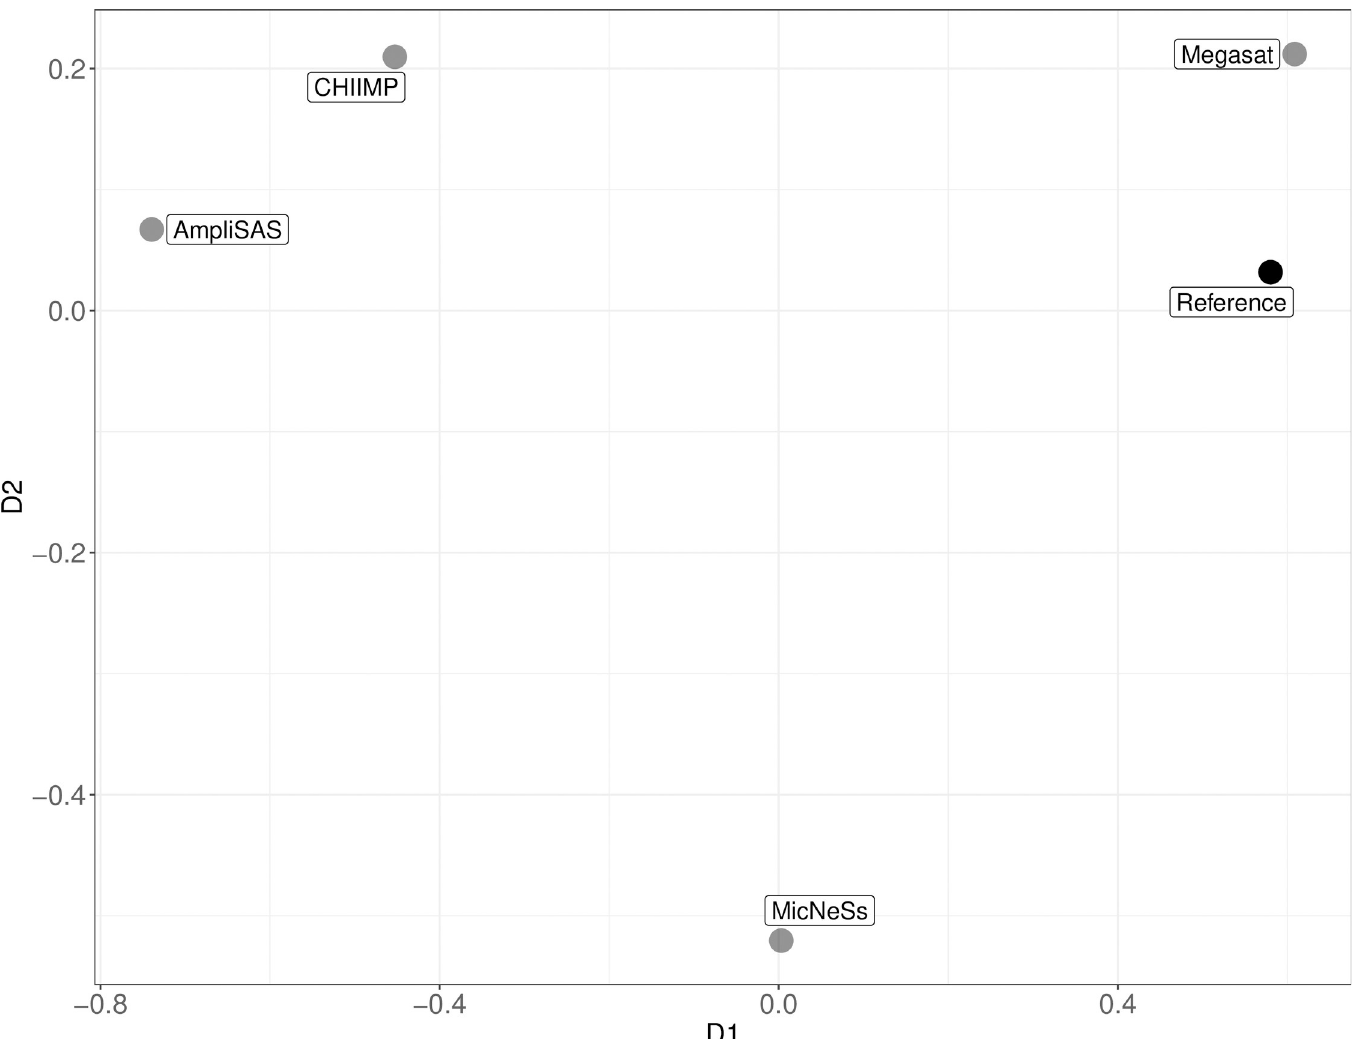
Fig 1. Multidimensional Scaling (MDS) of genotyping programs. Axes show distance values of distance matrix. Distance matrix was obtained from the comparison of consensus genotypes of each software and establishing minimum read depth of 16 (S2 Table in S1 File). The closer two programs are, the more similar their results are. Model statistics: two-dimensions ratio MDS using majorization, stress-1 value (normalized): 0.061, number of iterations: 17. Reference indicates consensus genotypes used as reference for comparison.